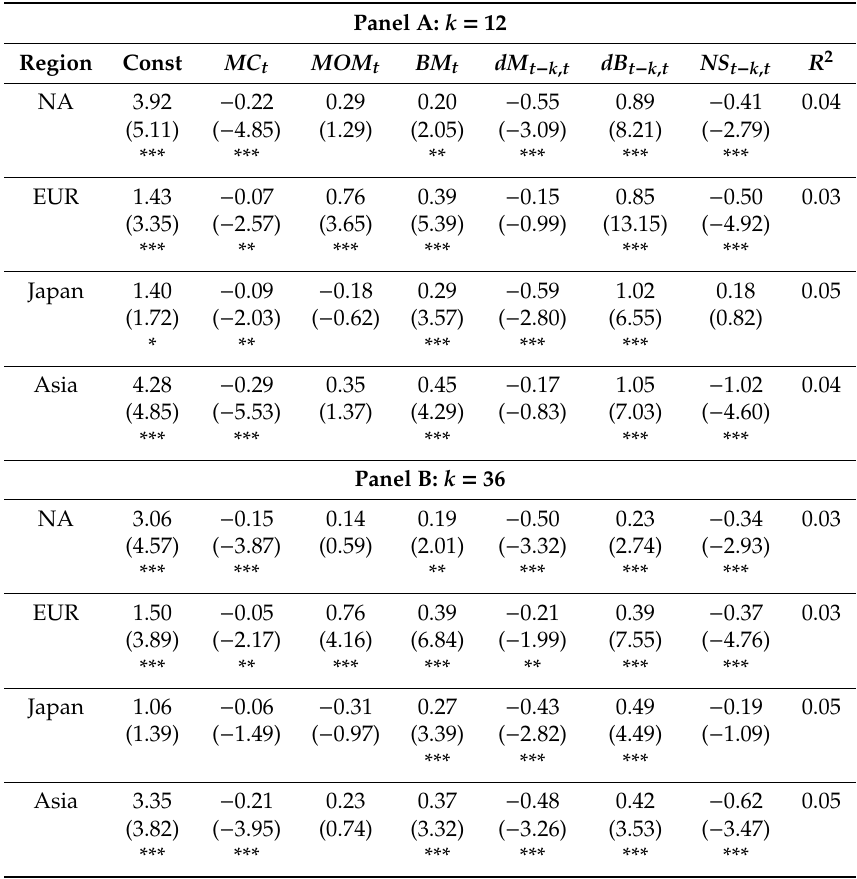
Table 3. Model (5) Regression Estimates—1991–2016. This table lists the results of Fama–MacBeth regressions using data representing twenty-three countries divided into the regions of North America (NA), Europe (EUR), Japan, and Asia the period 1991–2016. The cross section of time t + 1 returns (less the return on the 1-month Treasury) is regressed on characteristics observed in time t . Market capitalization, MC t , is the time t price multiplied by shares outstanding. Momentum, MOM t , is